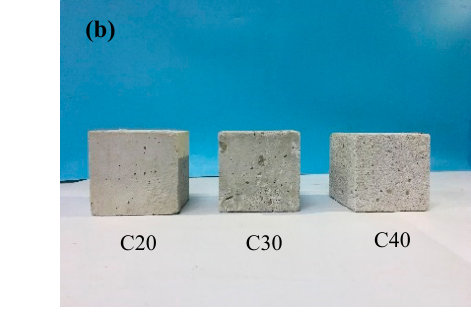
Figure 3. Appearance of sulfated concrete at the age of 20 days with different water–cement ratios: ( a ) before cleaning; and ( b ) after cleaning.